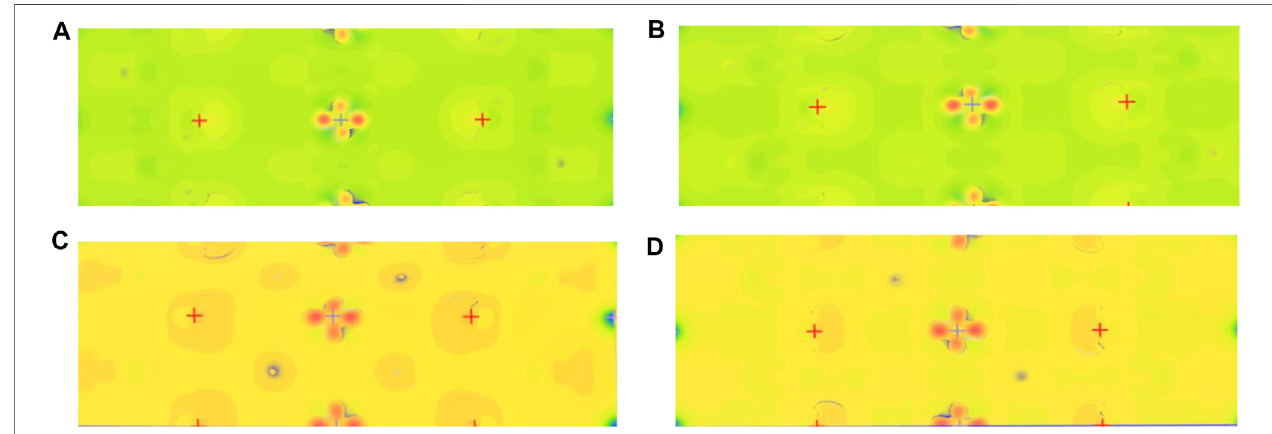
FIGURE5| ElectrondensitydifferenceofLi 1.0- x Al x Ni 1/3 Co 1/3 Mn 1/3 O 2 . (A) Theelectrondensitydifferenceimageofthepristineisshown. (B) When x (cid:2) 0.06mol,the color has not changed, and the coverage of electron cloud has expanded signi fi cantly, which suggests the conductivity has been enhanced due to more free electrons aroundatoms. (C) When x (cid:2) 0.10mol,thecolorofelectroncloudgets orange,and theelectron cloud ’ scoverage isbiggest,whichindicates itsconductivity ispromoted extremely. (D) When x (cid:2) 0.11 mol, its color has not changed, and its coverage has shrunk much.